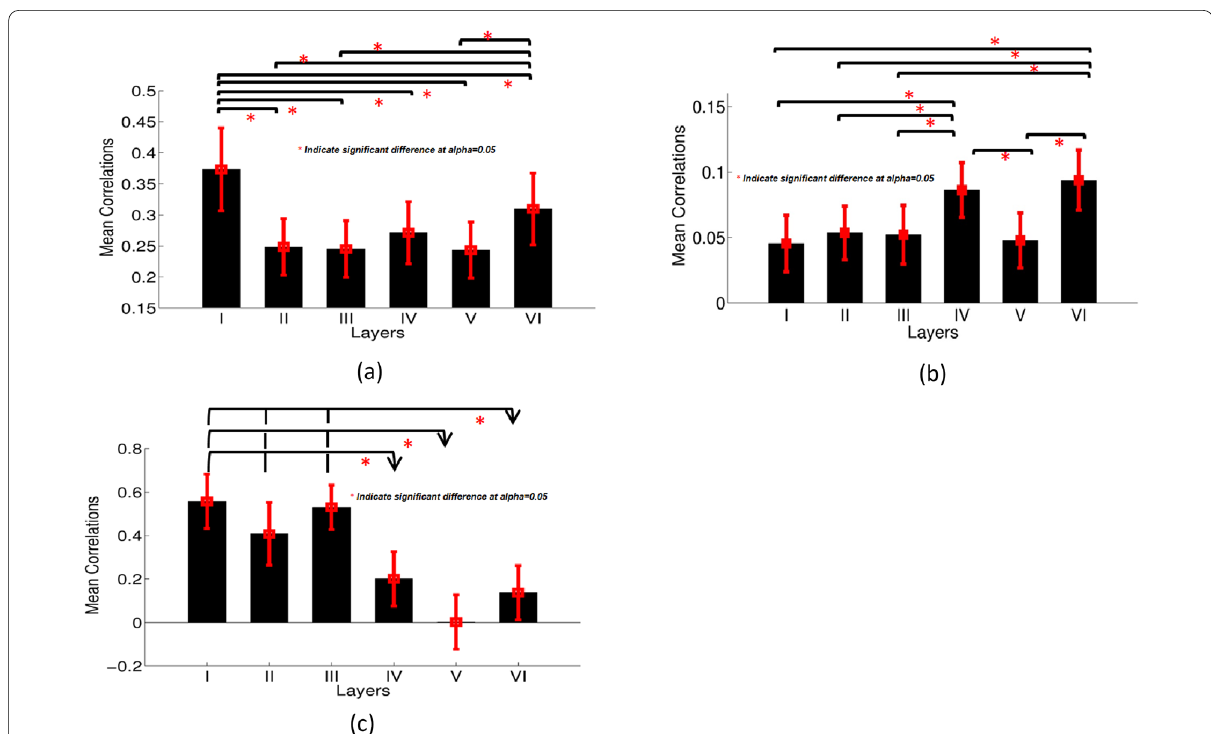
Fig. 8 a Mean thalamo-cortical FC values between the entire thalamus and six cortical layers after blind deconvolution, i.e., using latent neural time series; b mean FC between the sensory core thalamus (VPL) and six different layers of primary somatosensory cortex after blind deconvolution; c mean inter-hemispheric cortico-cortical laminar FC values after blind deconvolution. *Significant difference with p (corrected) < 0.05. The error bar indicates the estimated standard